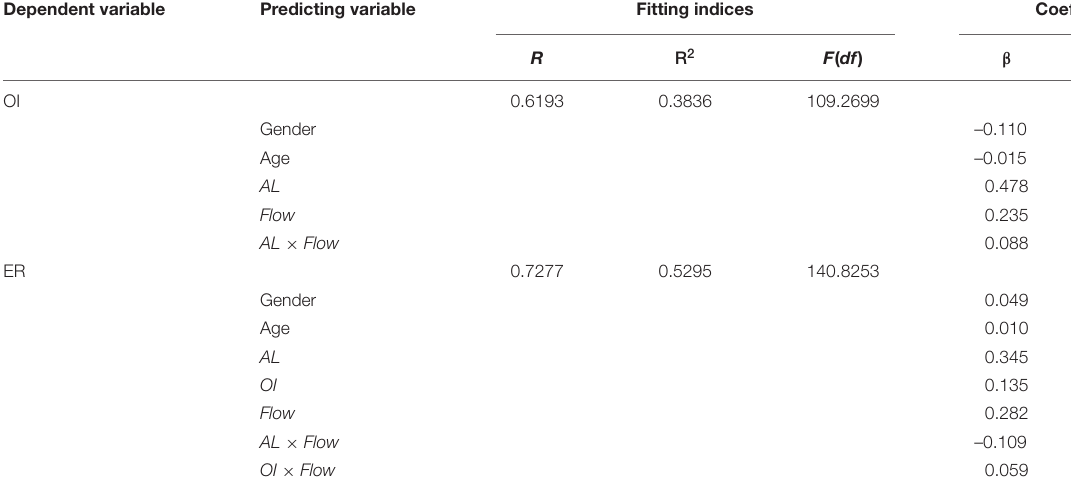
TABLE 4 | Conditional process analysis.